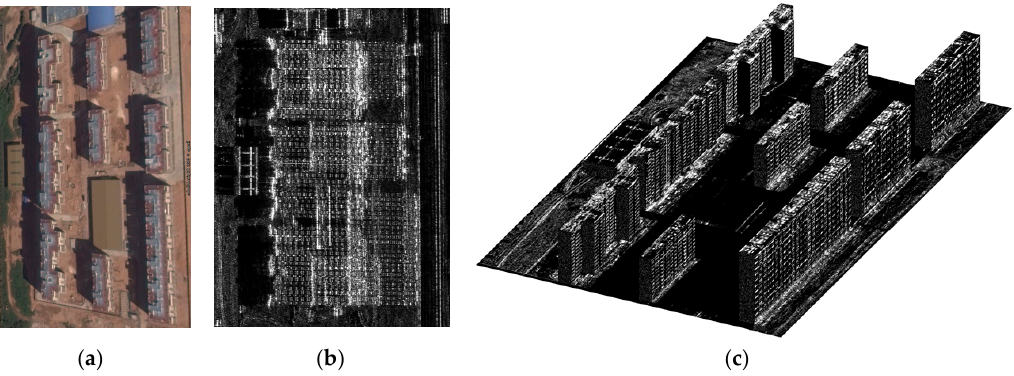
Figure 13. 3D imaging results of a residential area. ( a , b ) Google Earth and SLC images of the building, respectively; ( c ) The reconstruction result of the building after calibration and focusing processing.